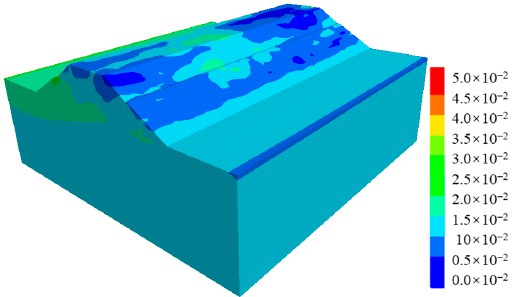
Figure 14. Displacement contour of the fill subgrade after earthquake.